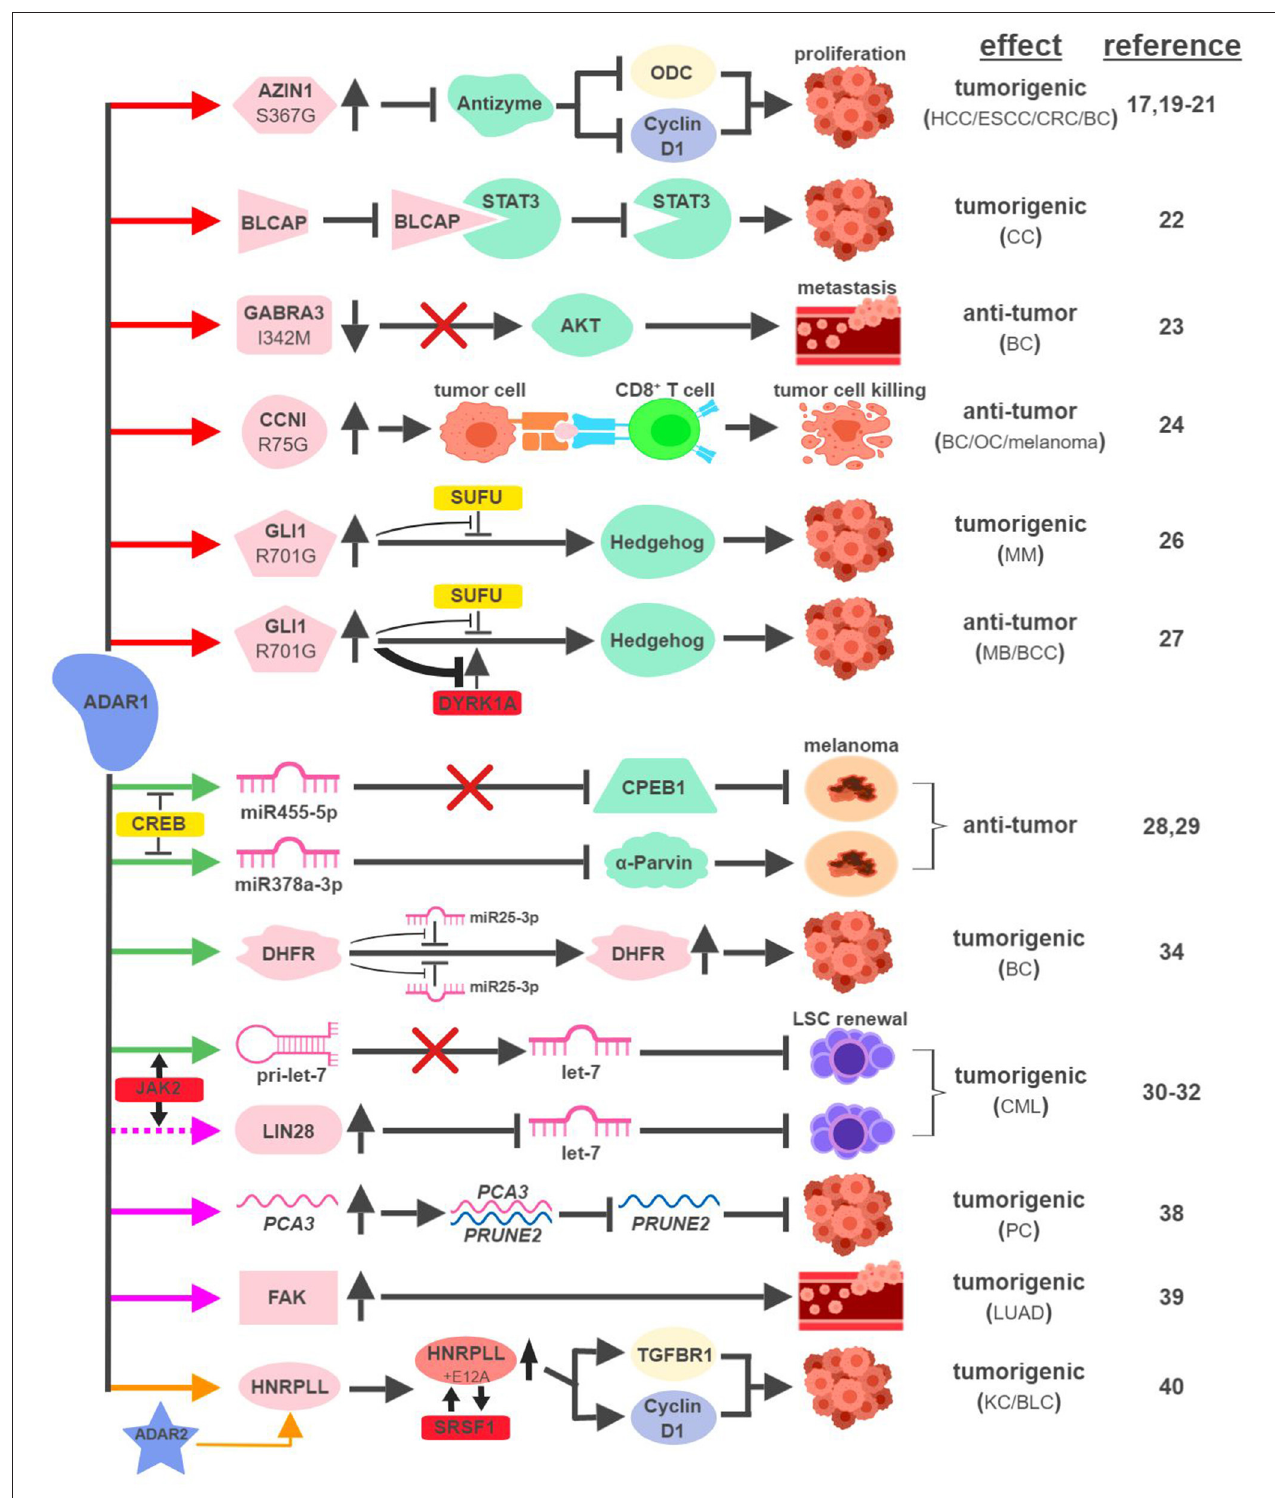
FIGURE 2 | ADAR1-mediated RNA editing in cancer development. The color of the first arrow in each pathway indicates the mechanism (refer to Figure 1 ) by which ADAR1 regulates its direct targets, depicted in pink icons or shapes. Dashed lines indicate suggested/unproven functions/relationships. Additional activators and inhibitors of specific pathway steps are depicted in red and yellow rounded rectangles, respectively. Specific diseases and phenotypes/functions affected by ADAR1-mediated RNA editing are only labeled in the first appearance (ex. proliferation…etc). HCC, hepatocellular carcinoma; ESCC, esophageal squamous cell